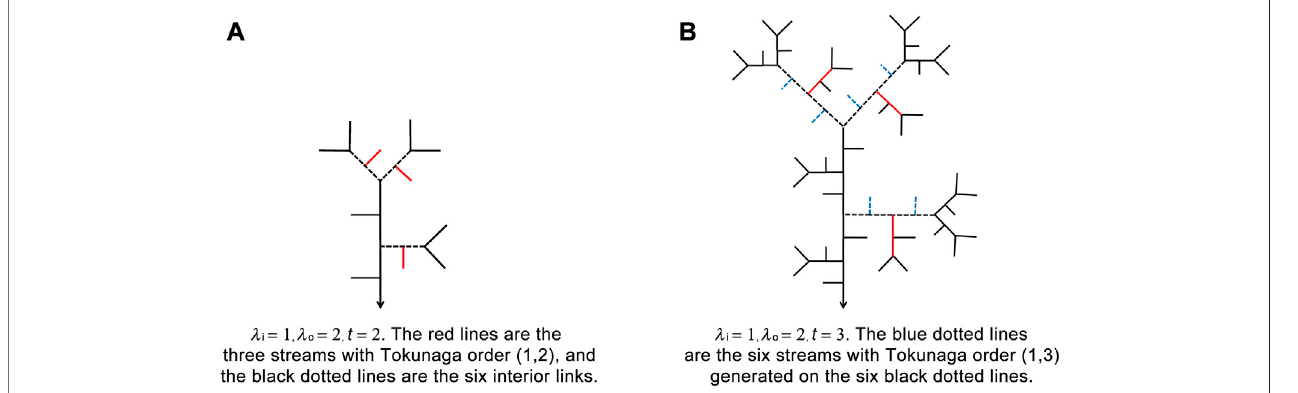
FIGURE 7 | Streams with Tokunaga order (1,3) in QU-IBTNs are generated using λ i (cid:2) 1, λ o (cid:2) 2 from the second step in (A) to third iterative step in (B)